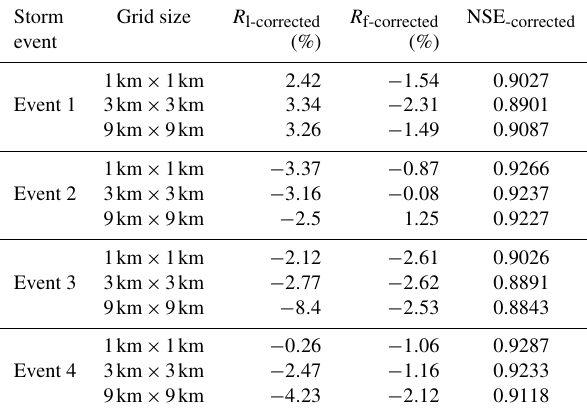
Table 10. Simulation results of the coupled atmospheric–hydrologic systems based on the corrected gridded rainfall for four storm